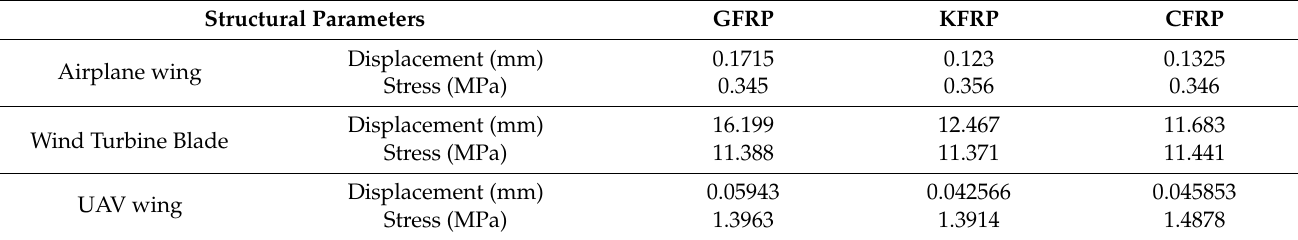
Table 4. Comparative FSI results of various composite materials.